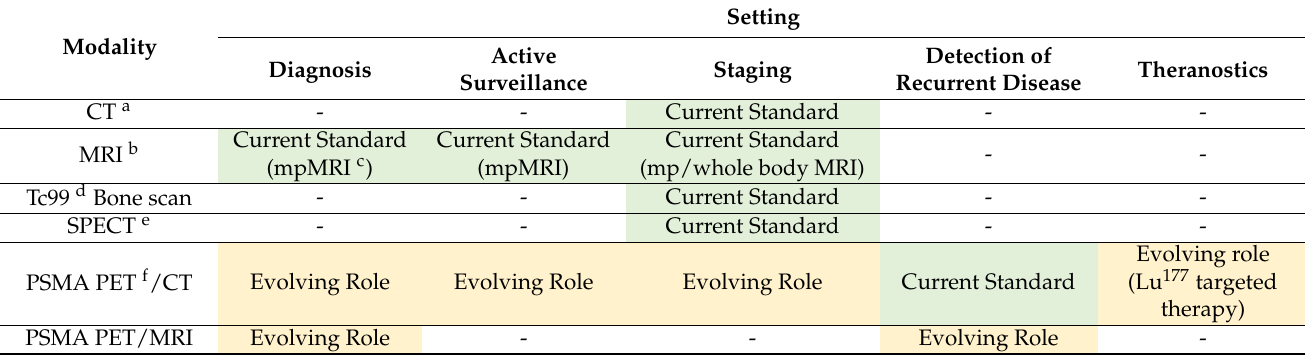
Table 2. Summary of Imaging modalities and their role in Prostate